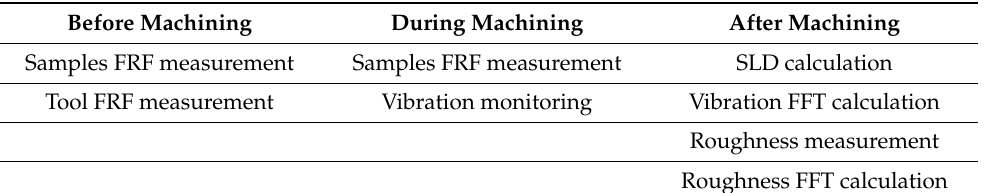
Table 1. Conducted Table 1 . Conducted tasks .